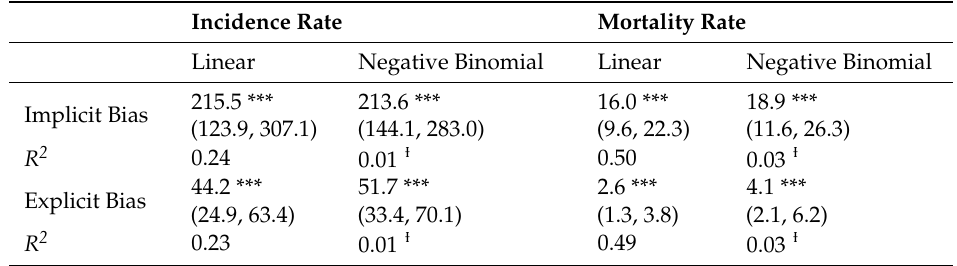
Models estimate COVID-19 outcome rates per 10,000 individuals (and associated 95% confidence intervals). Ɨ Pseudo R 2 . *** p < 0.001